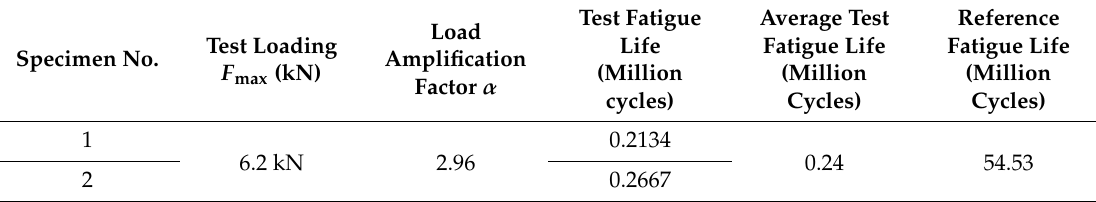
Table 3. Loading parameters and fatigue life results in ITBF test.